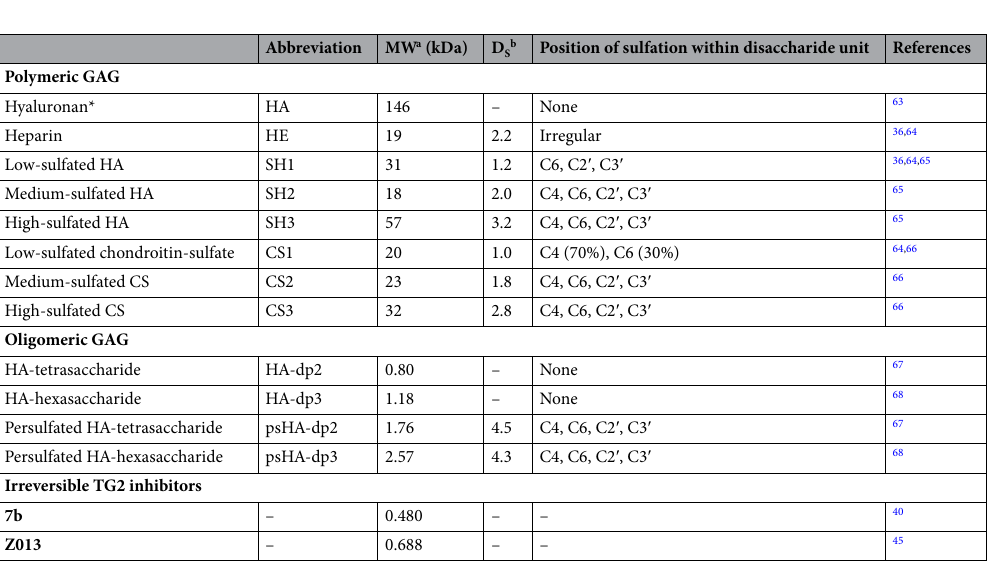
Figure 4. Schematic overview of the results and proposed mechanisms. When inactive TG2 (closed form) is pre-incubated with sulfated GAG derivatives in the absence of Ca 2+ , inhibition of transamidase activity is possible. Thereby, sulfated GAG presumably act as a “molecular staple” and stabilize the closed conformation of TG2. Furthermore, they might occupy the N-terminus (and induce conformational changes) as well as Ca 2+ binding sites. When sulfated GAG are incubated with Ca 2+ -activated TG2 (open form), no inhibition of transamidase activity is observed.